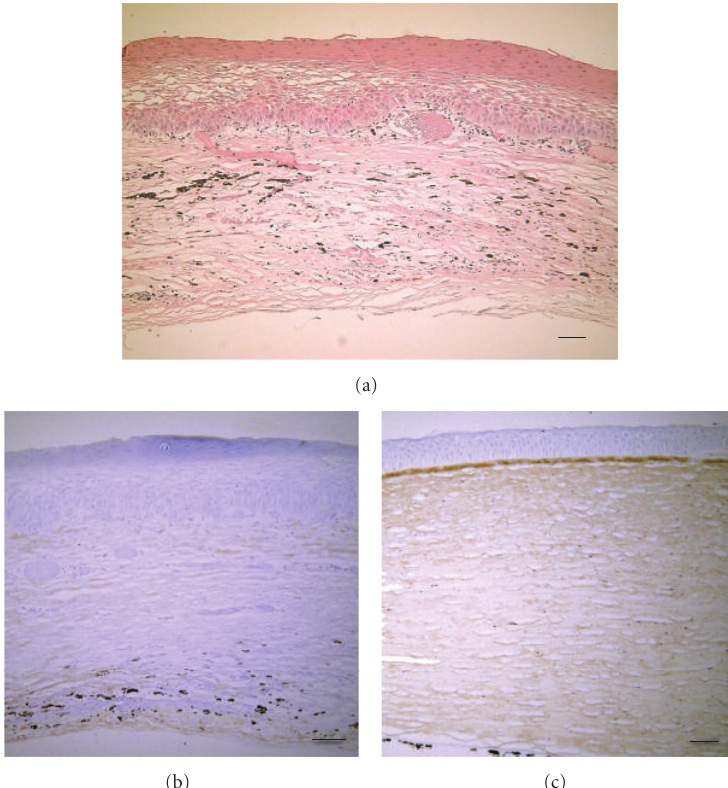
Figure 4: The central cornea with HE staining (a). The corneal epithelium was thickened and keratinized. Bowman’s membrane was absent. The stroma was consisted of irregular collagen, fibroblast-like cells, pigmented cells, blood vessels, and presumed inflammatory cells. The corneal endothelium and Descemet’s membrane were absent. Immunohistochemistry for Collagen types I (b) and (c). The protruding cornea (b). The peripheral cornea (c). Collagen type I was positive strongly in the peripheral cornea (c) and weakly in protruding cornea (b). Bar: 50 μ